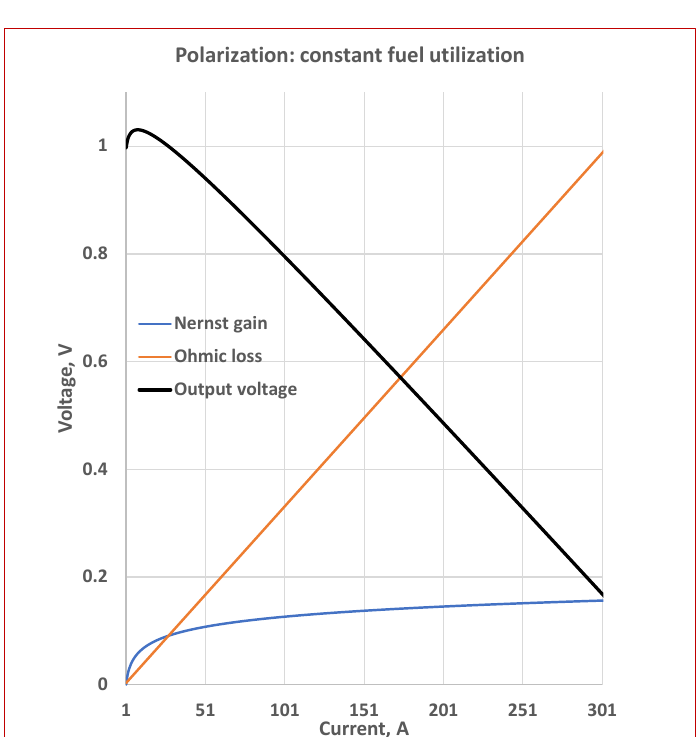
Figure 1. Polarization characteristics for the constant fuel utilization condition; the Nernstian gain and the ohmic loss are plotted